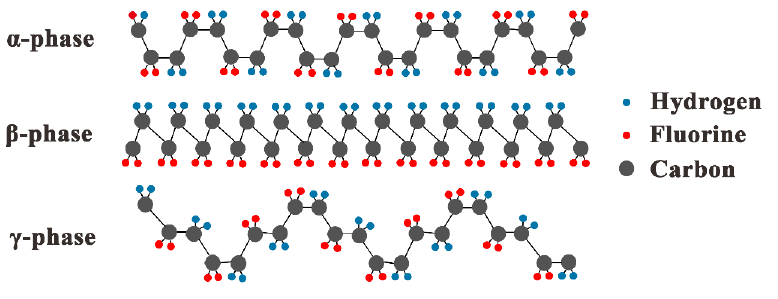
Figure 1. Structures of α, β, and γ phase polyvinylidene fluoride (PVDF).